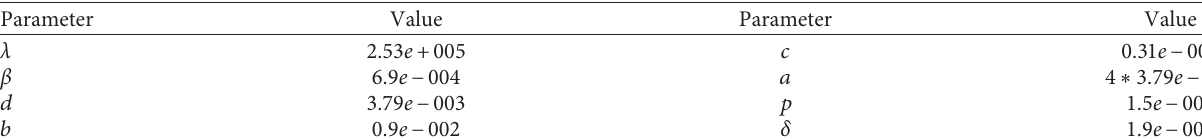
Table 4: Parameters in Figure 2.